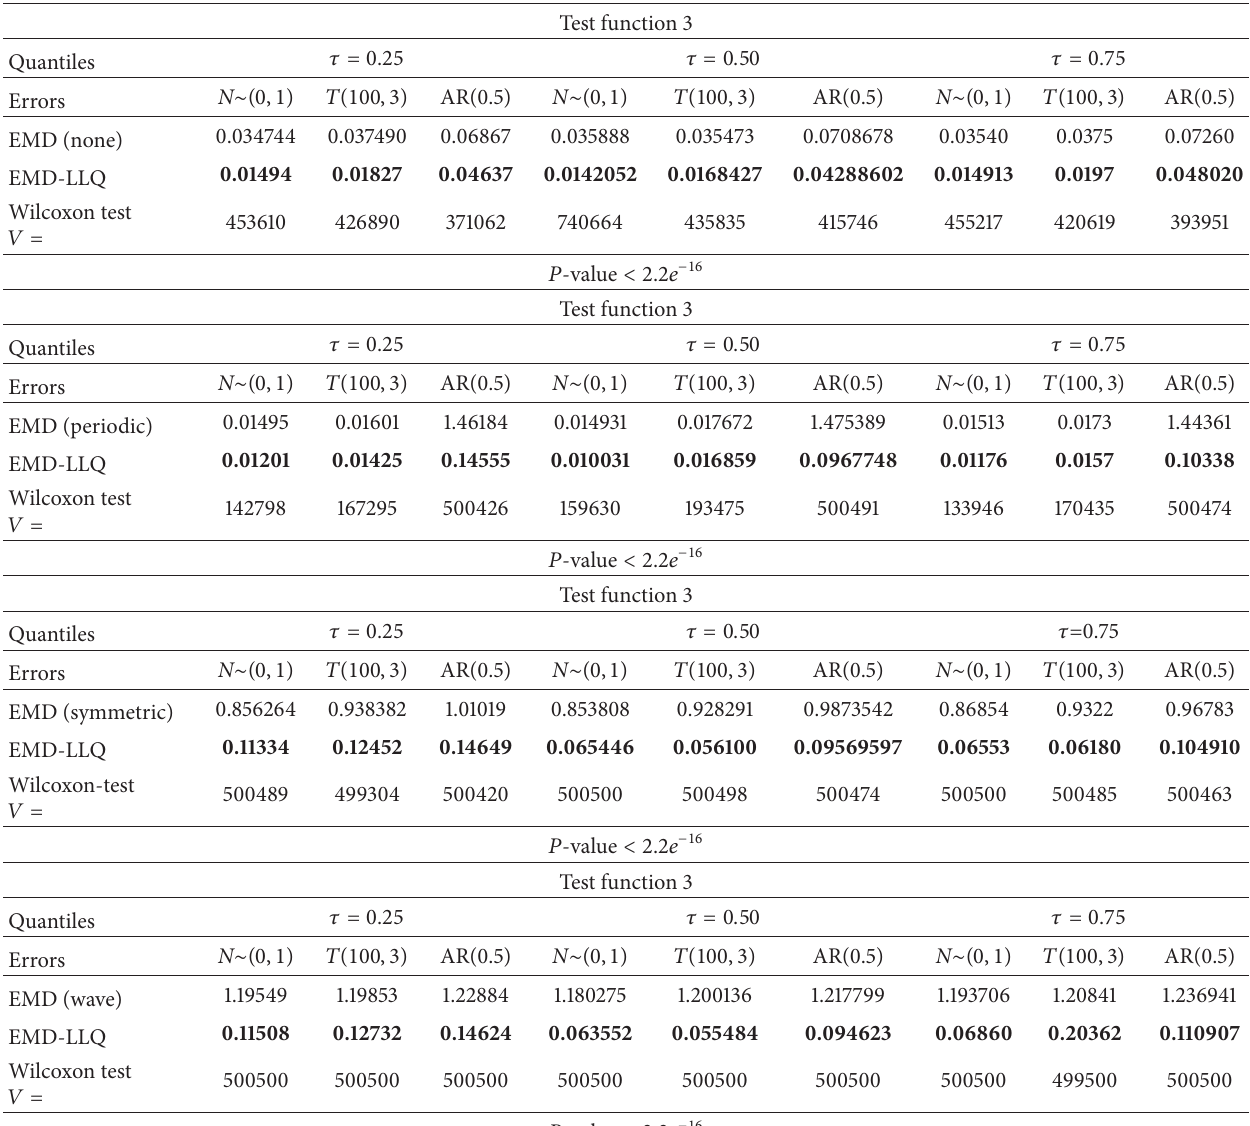
Table 4: The MSE of the classical EMD and proposed method under variety of boundary solution noise structure, different values of quantile 𝜏 (0.25, 0.50, and 0.75), and sample size =